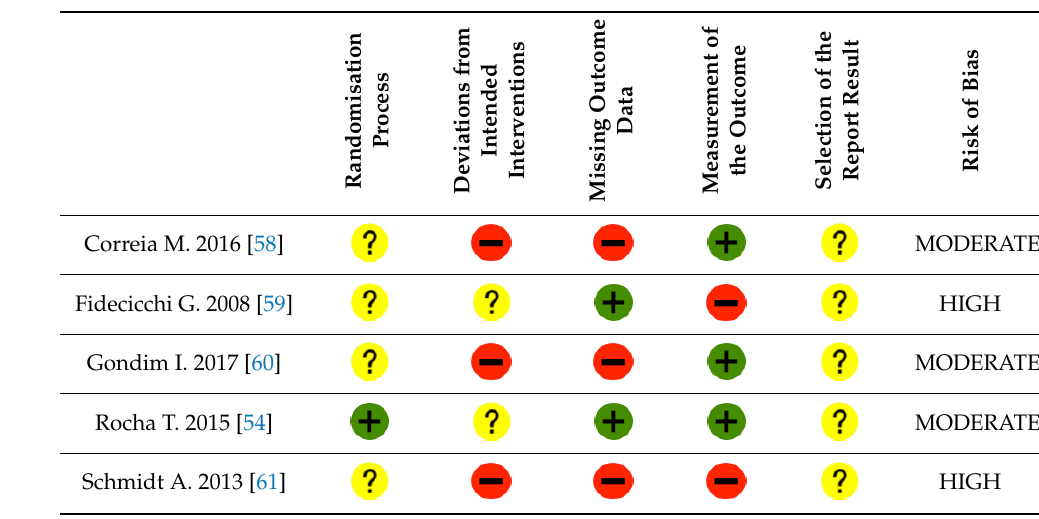
Table 4. Synthesis of the risk of bias assessment on pump techniques.